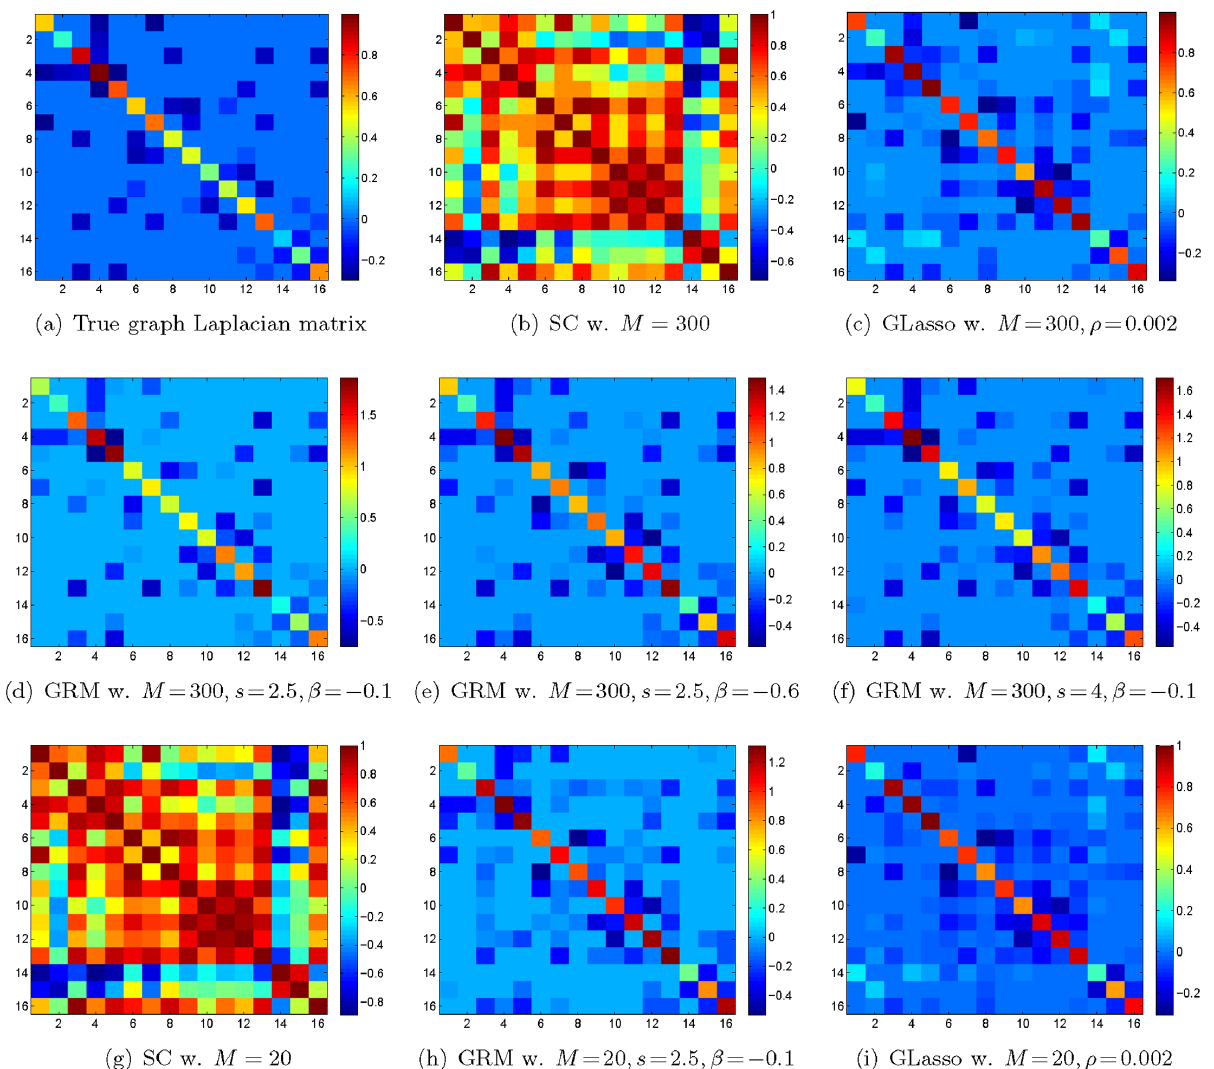
Fig 2. Simulation results. Simulation results on a 16-vertex random graph with its Laplacian matrix shown in (a). The data included M = 300 signals on the graph for (b) – (f) and M = 20 signals for (g) – (i). Each signal was a linear combination of the first 6 eigenvectors of the graph Laplacian. For M = 20 or 300, the GRM significantly outperforms the compared methods, namely the sample correlation and the graphical Lasso.